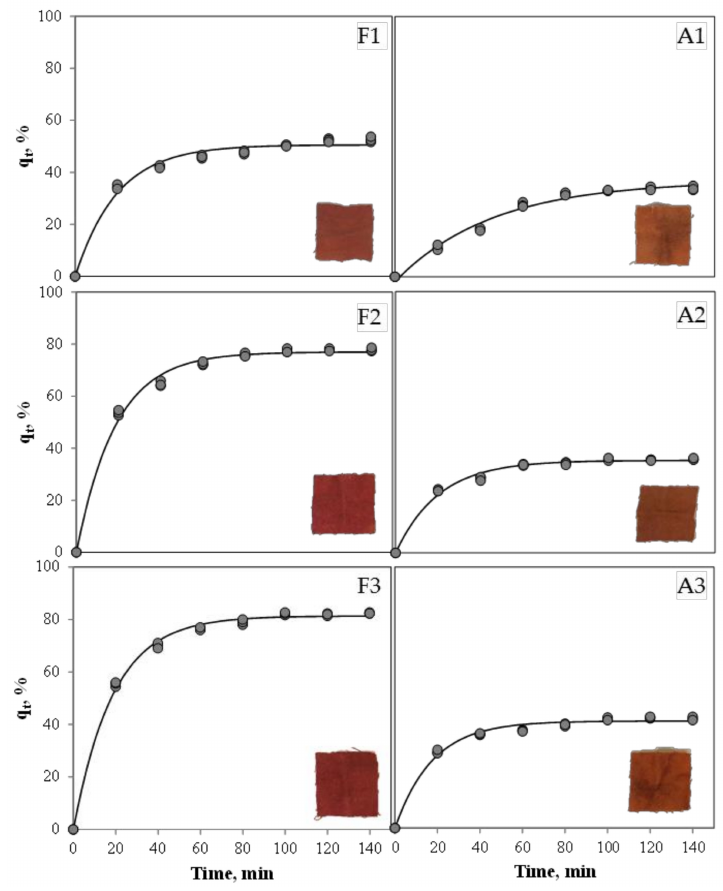
Figure 1. Effect of mordant type and concentration on pigment sorption on wool. Circles represent experimental data points and continuous lines represent the Lagergren model.